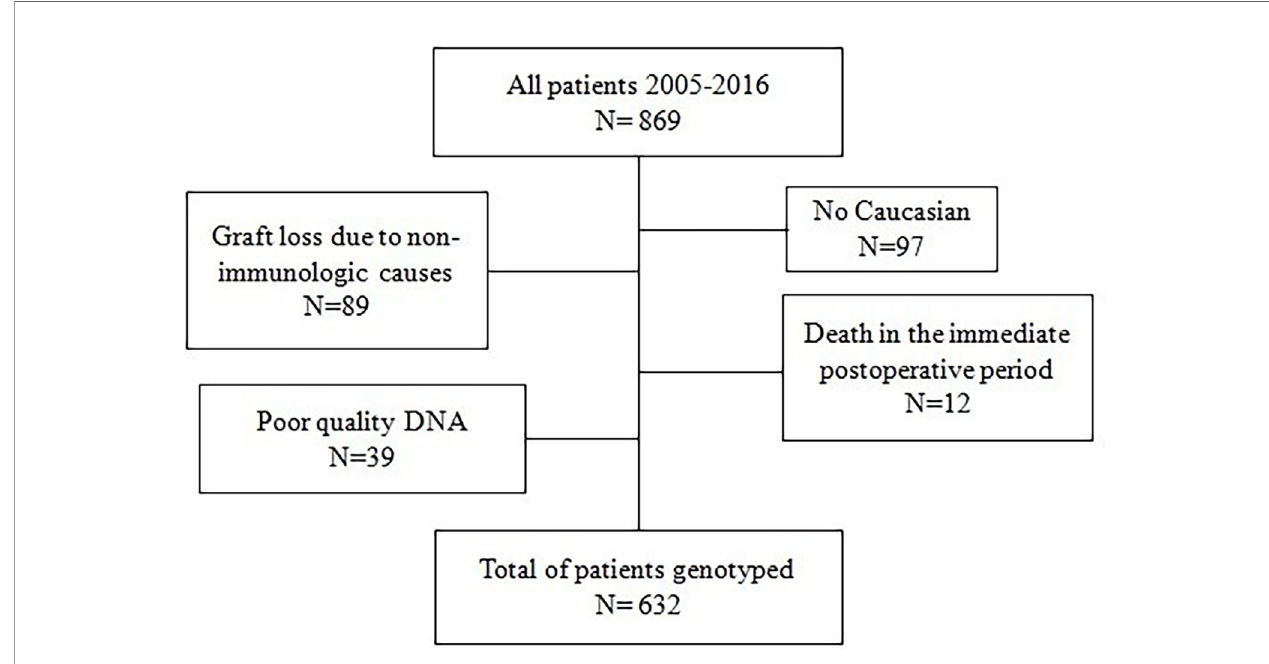
FIGURE 1 | Flowchart of the patients included in the